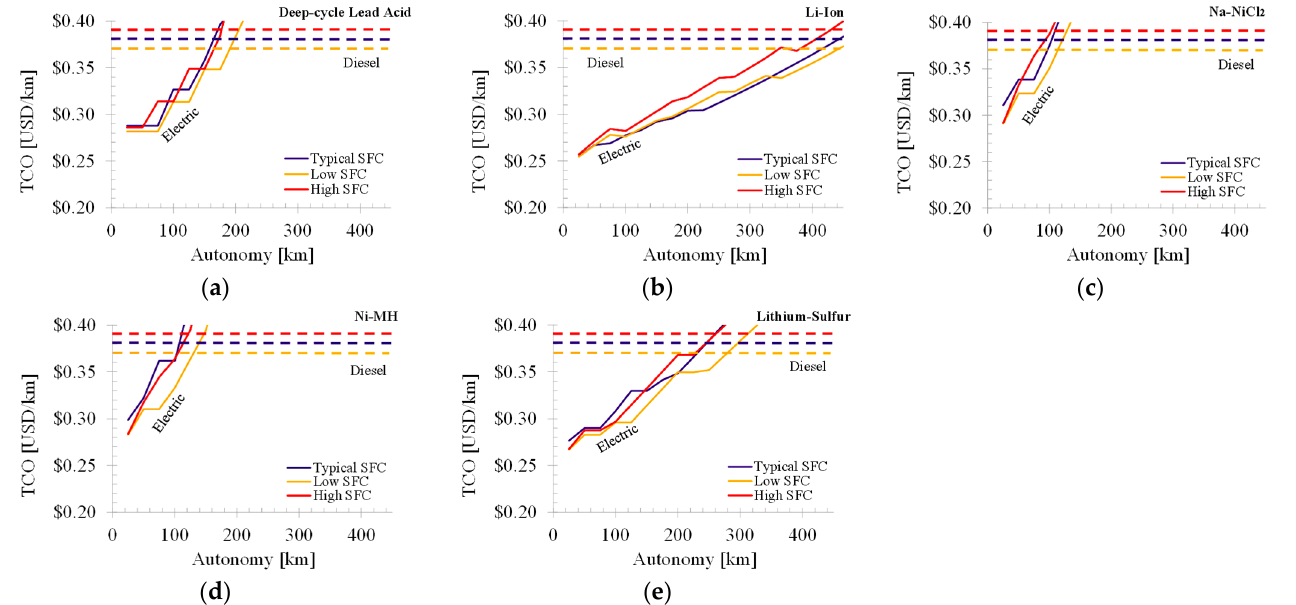
Figure A2. Impact of the desired minimum autonomy on the TCO considering ( a ) deep-cycle lead acid, ( b ) Li-Ion, ( c ) Na-NiCl 2 , ( d ) Ni-MH, and ( e ) lithium-sulfur batteries for low SFC, typical SFC, and high SFC scenarios. Note: Skipped lines correspond to the diesel configuration; Solid lines correspond to the electric configuration.